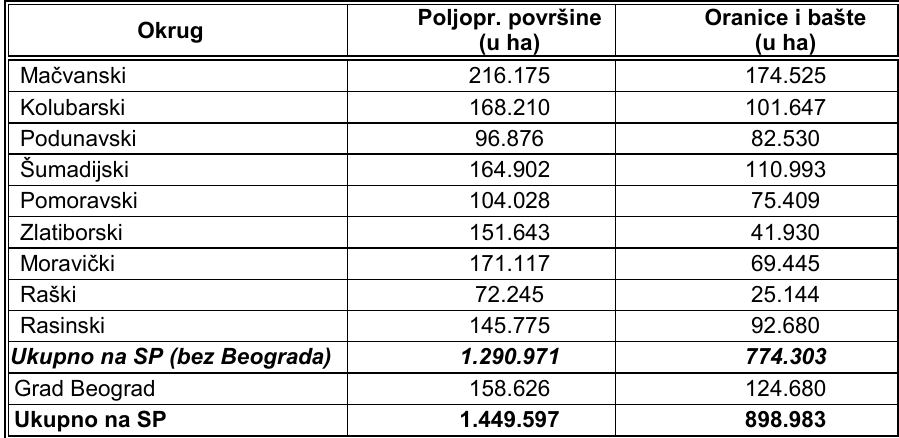
dive površine. U tabeli 2 dati su podaci o poljoprivrednim površinama i oranicama na strategijskom